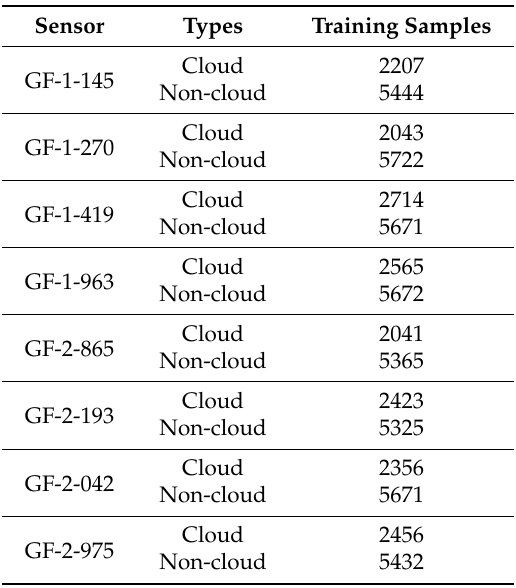
Table 3. Training samples for eight selected images.